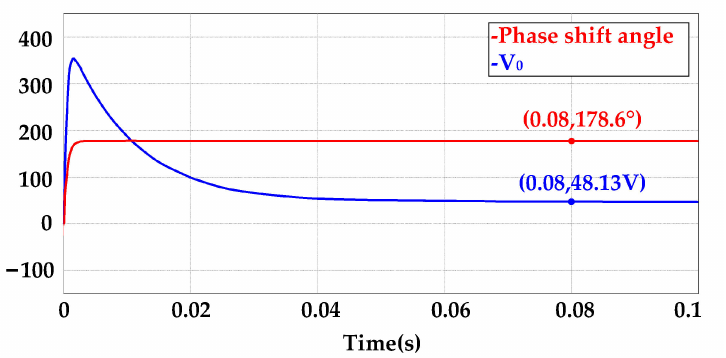
Figure 11. The waveform of output voltage and the phase shift angle in WPT system without